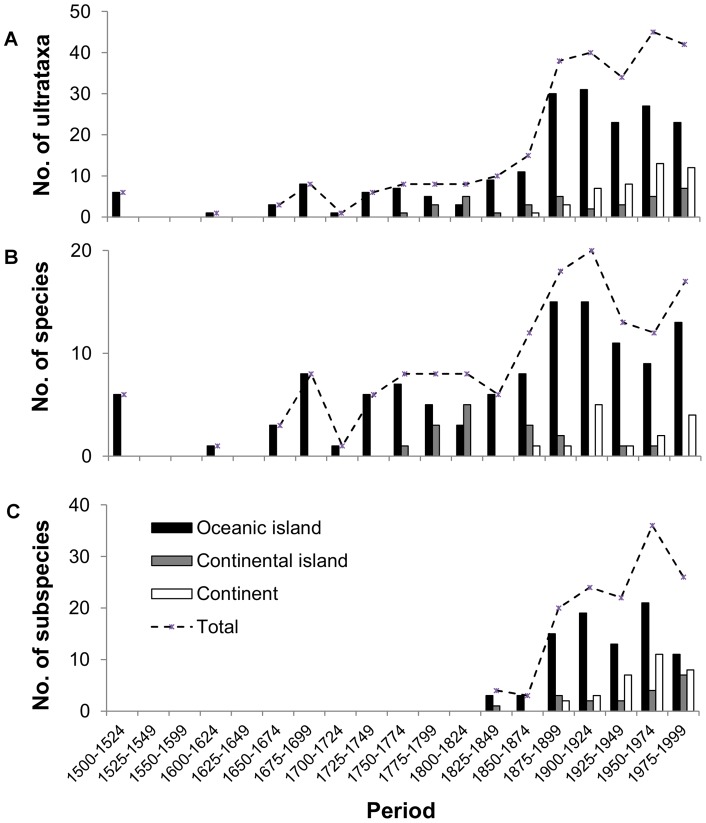
Number of extinctions per 25-year period by landmass (black: oceanic island, grey: continental island, white: continent) for A) ultrataxa (nultrataxa  = 279), B) species (nsp  = 150) and C) subspecies (nssp  = 138).Totals include ultrataxa classified as Extinct (nsp  = 125 and nssp  = 92), Extinct in the Wild (nsp  = 4 and nssp  = 1), Possibly Extinct (nsp  = 12 and nssp  = 42) and Possibly Extinct in the Wild (nsp  = 1 and nssp  = 0). The dashed line indicates the number of extinctions per 25-year period for all landmass types combined. Since 2000, two subspecies and two species extinctions have been recorded on oceanic islands, none on continental islands and a subspecies and a species on continents.